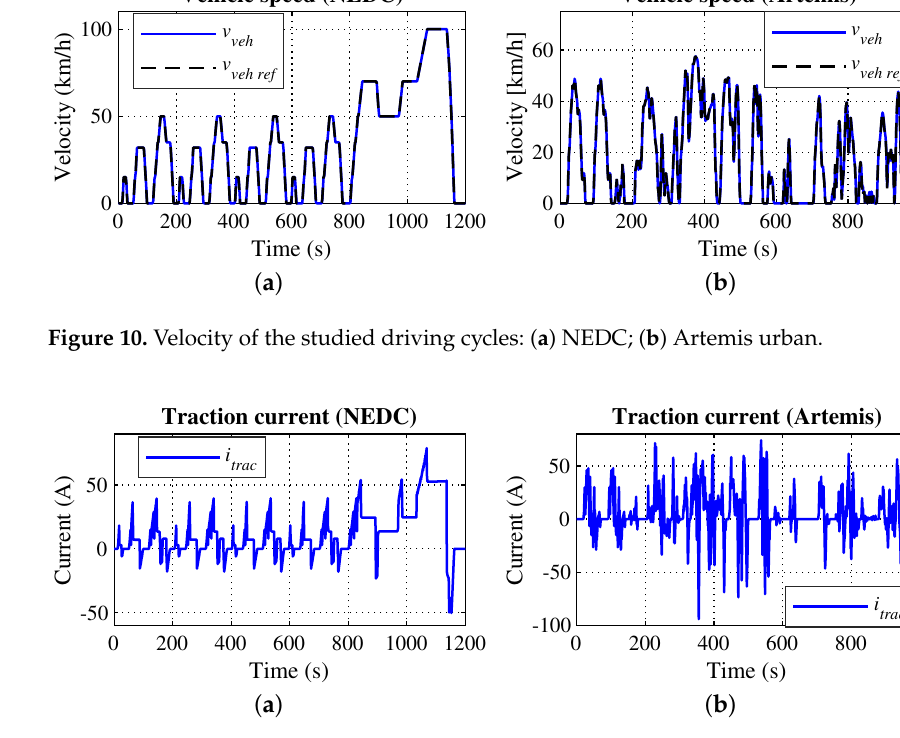
Figure 11. Traction currents in the studied driving cycles: ( a ) NEDC; ( b ) Artemis